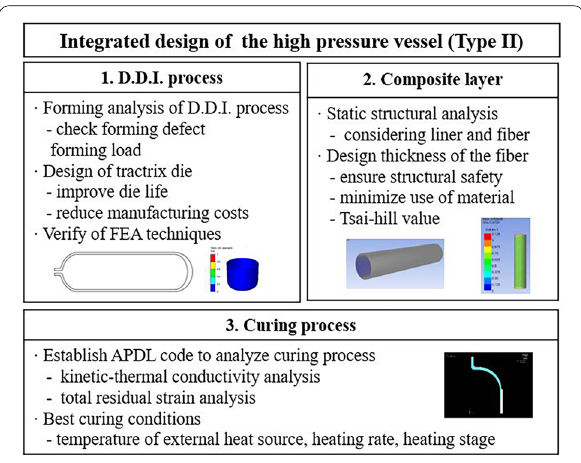
Figure 1 Configuration of the integrated design of CNG composite pressure vessel (Type II)